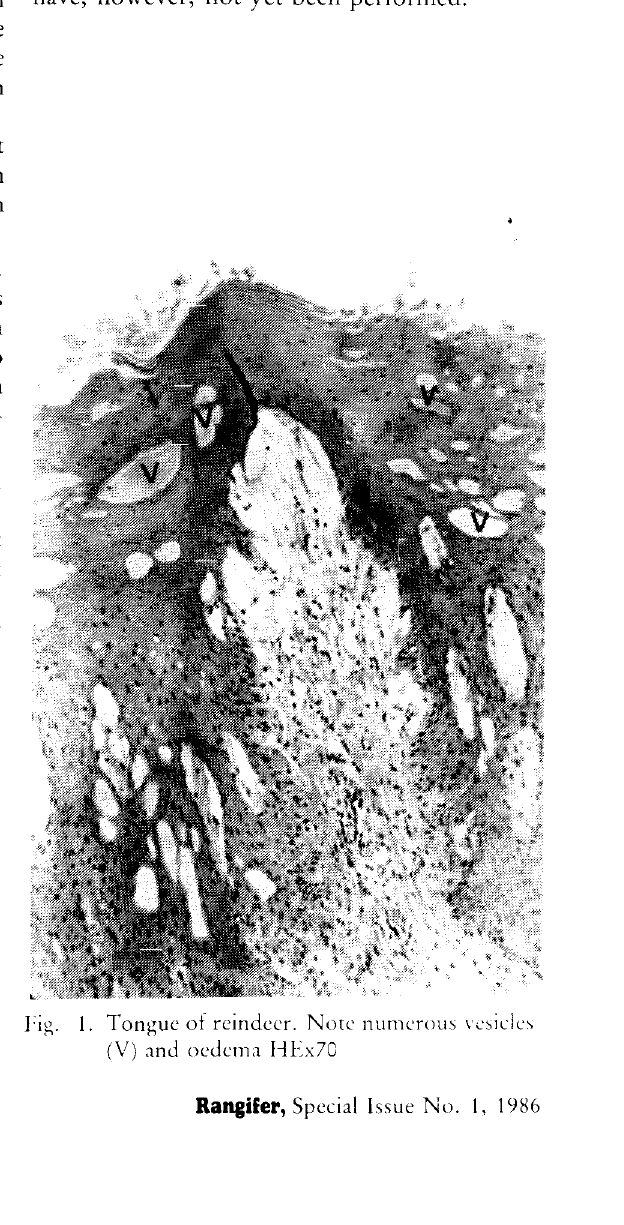
Fig. 1. Tongue of reindeer. Note numerous